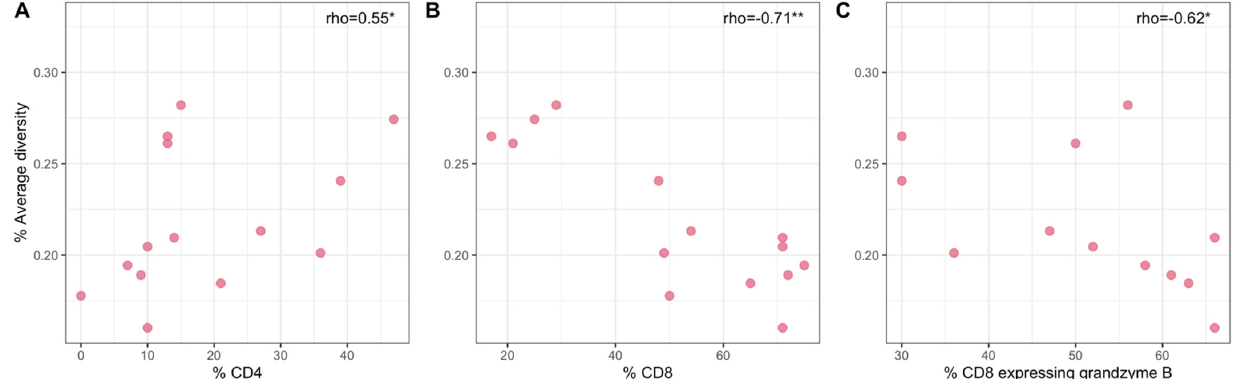
Figure 6. Relationships between SIV diversity and the frequency of CD4+ T cells ( A ), the frequency of CD8+ T cells ( B ), and the frequency of CD8+ T cells expressing granzyme B ( C ) in lung granuloma samples of the Mtb R cohort. Asterisks denote * for p -value < 0.05, ** for